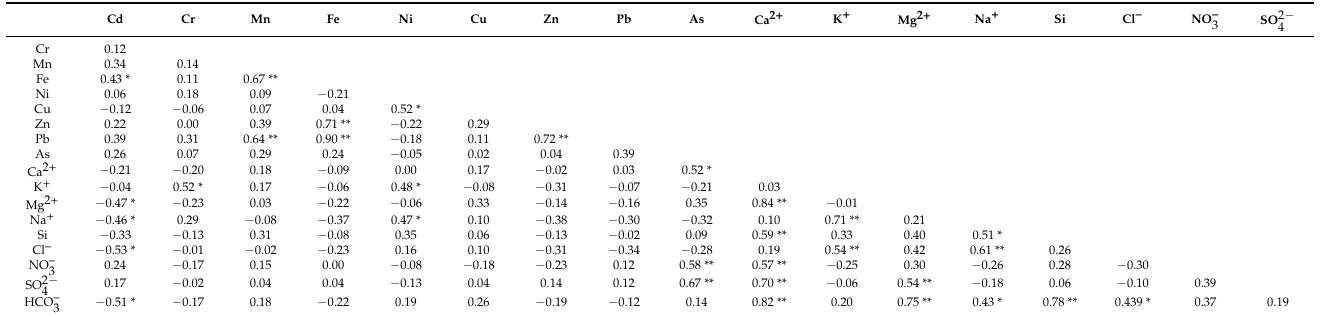
Table 4. The Pearson correlation analysis of heavy metals in DLQ.